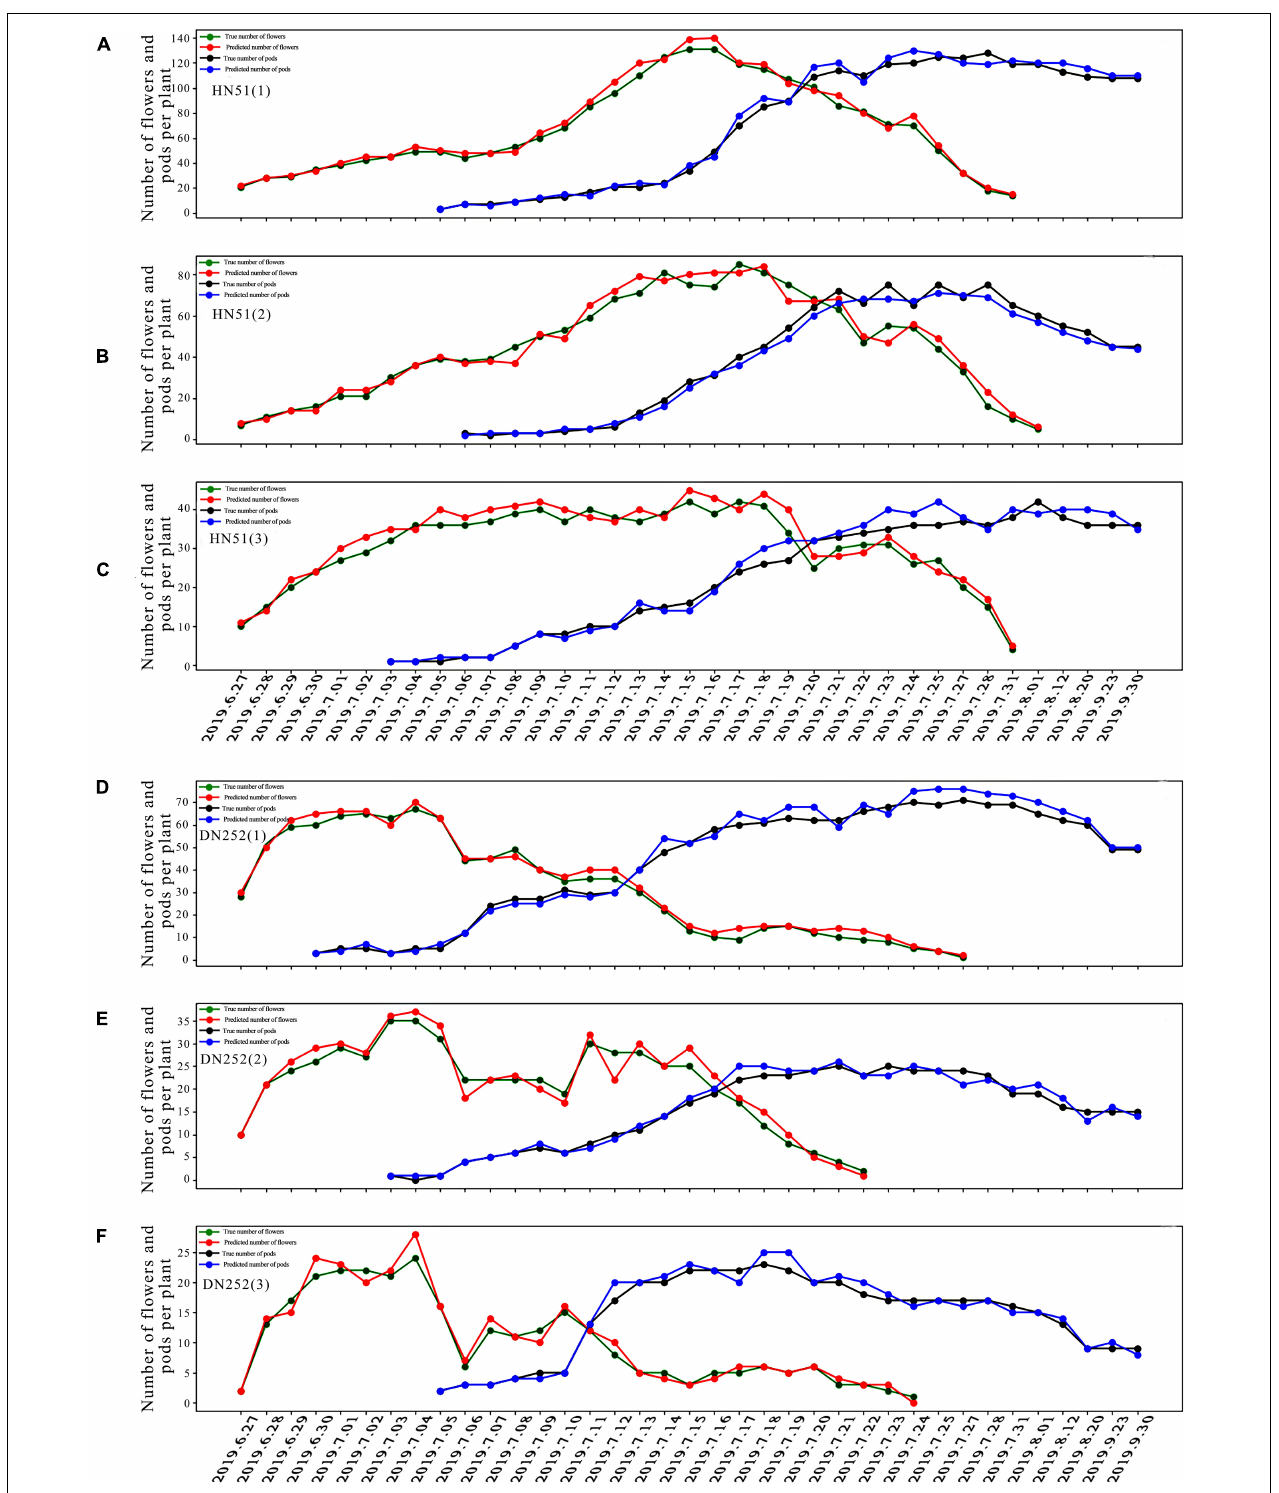
FIGURE 6 | Plots of flower and pod counting over time for three plants of soybean cultivars HN51 and DN252. (A–C) Plots of the number of flowers and pods of three plants of variety HN51 over time. (D–F) Plots of the number of flowers and pods of three plants of variety DN252 over time.